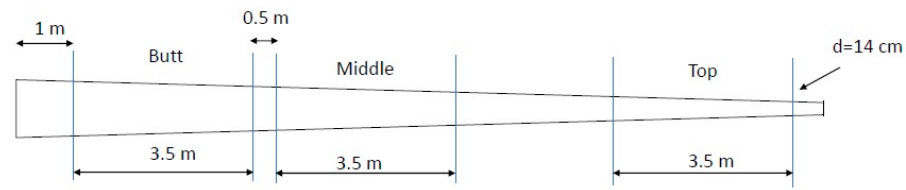
Figure 1. Diagram presenting divisions of the trunk into logs. The sawn timber was kiln-dried to an average final moisture content of 12% (+/ − 1.7%). After drying, timber was machined to the final dimensions of 40 × 138 × 3500